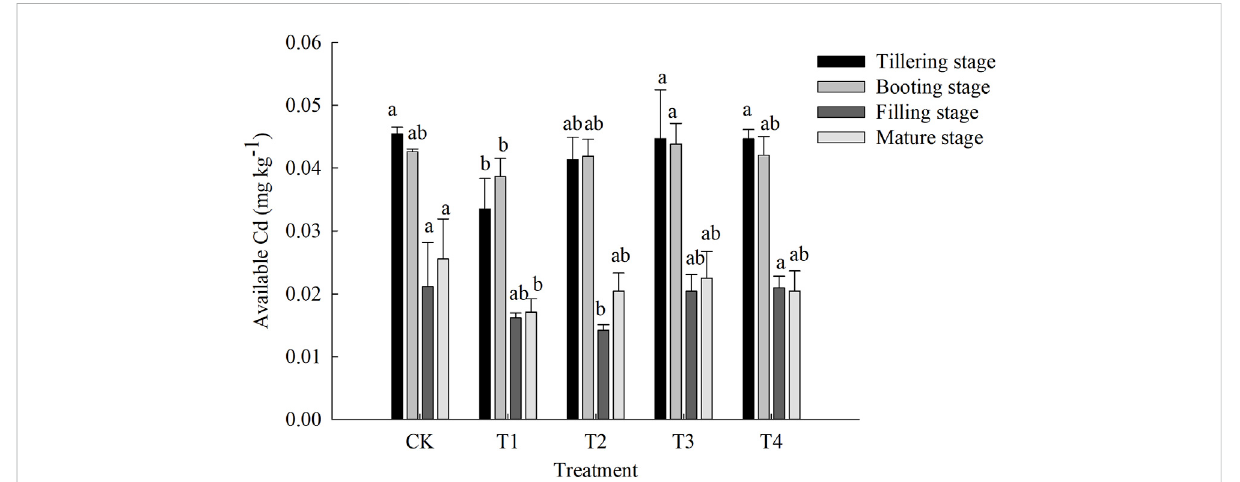
ConcentrationsofavailableCdinsoilwithdifferentstabilizingmaterials.Datapointsanderrorbarsrepresentmean±S.D.ofthreereplicates( n = 3). Different letters indicate a signi fi cant difference between different treatments in the same period ( p < 0.05).